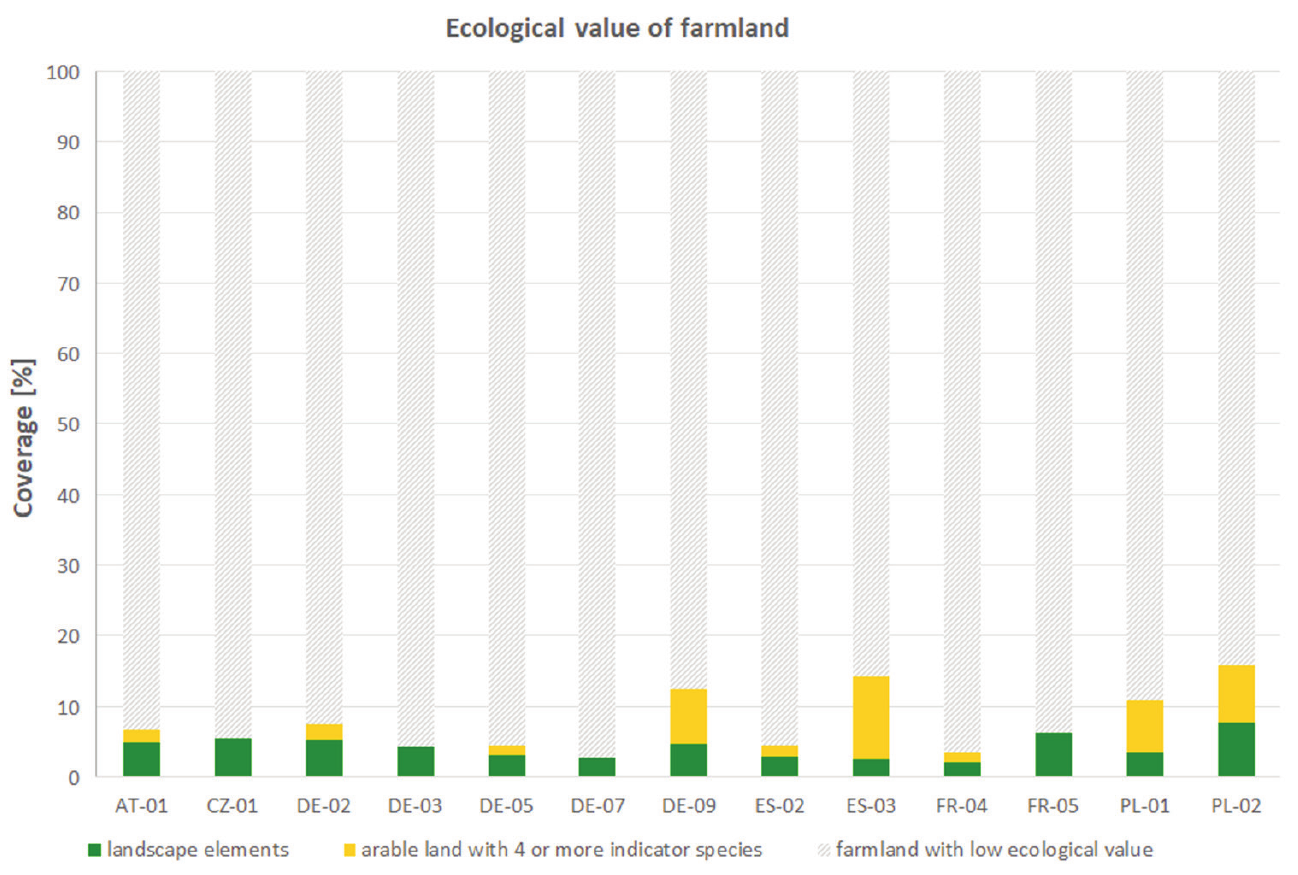
Figure 9. Extent of farmland with high ecological value in some arable regions in 2016: landscape elements including buffer strips and arable land with four indicator